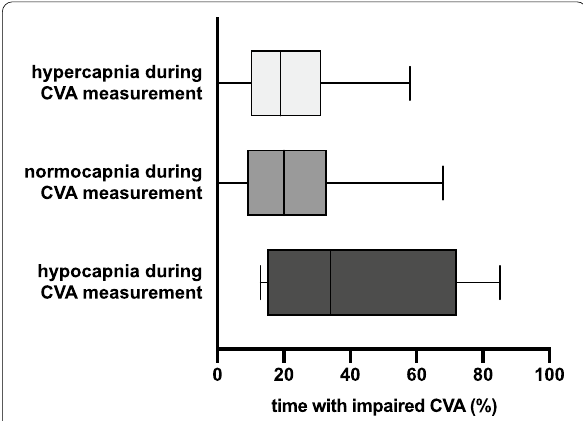
The variables position (prone vs. supine), inhalational nitric oxide, extracorporeal membrane oxygenation, and the Sequential Organ Failure Assessment score during measurement were included in the initial model and eliminated during the stepwise-backwards reduction ARDS: acute respiratory distress syndrome a Vs. Normo- and hypercapnia b Etiologies were categorized as “community-acquired” and “hospital-acquired” for the linear mixed model